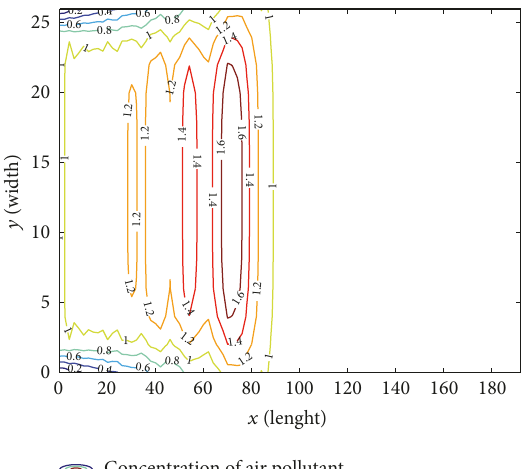
Figure 15: Contour plot of concentration of air pollutant levels for 𝑅 = 0. 003 | sin (𝑥𝑡)| sec −1 .